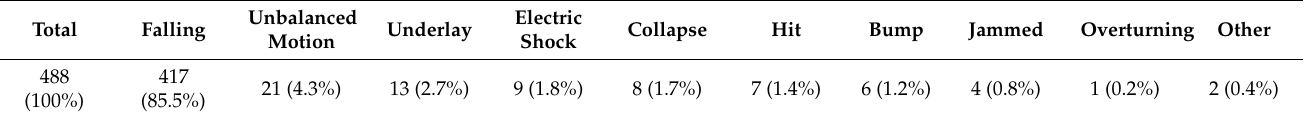
Table 3. Accident status by type of